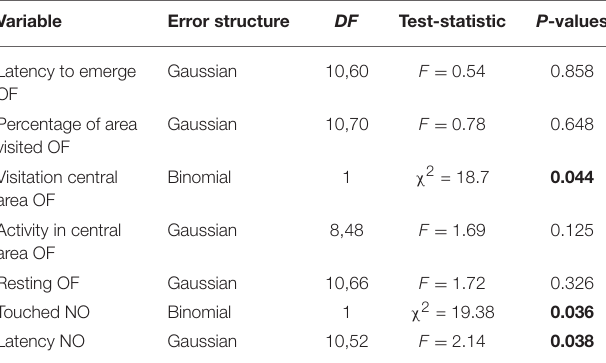
TABLE 7 | Model outputs (GLMs) testing for family × environment interactions fitting an interaction between maternal line and treatment as explanatory variables on behavior shown in the open field test (OF) and the novel object test (NO). Variable Error structure DF Test-statistic P